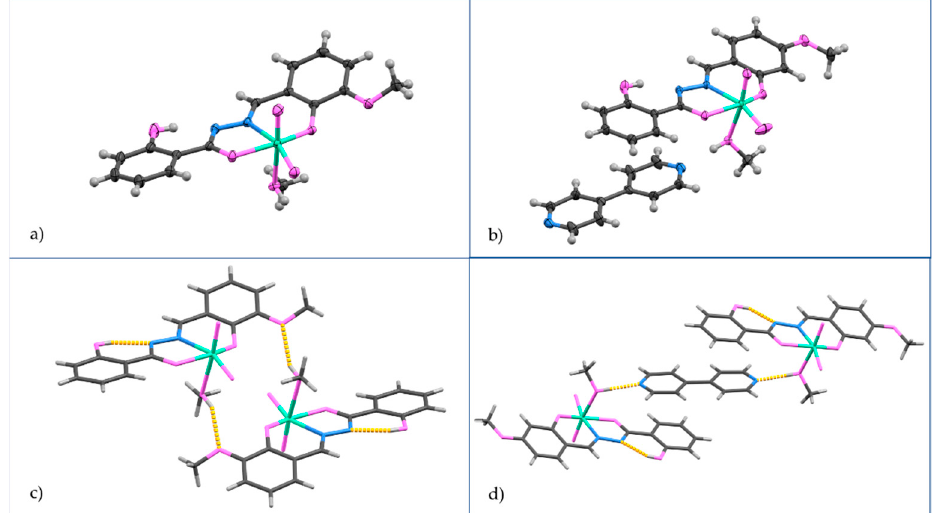
Figure 1. Molecular structure of ( a ) complex [MoO 2 (L 3OMe )(MeOH)] and ( b ) complex co-crystal [MoO 2 (L 4OMe )(MeOH)]·4,4-bpy. Carbon atoms are colored dark gray, hydrogen atoms light gray, oxygen atoms pink, nitrogen atoms blue, and molybdenum atoms turquoise. Molecules are connected via hydrogen bonds into supramolecular dimers. In the case of ( c ) [MoO 2 (L 3OMe )(MeOH)] hydrogen bonds are realized through methanol-methoxy group interaction, while in ( d ) [MoO 2 (L 4OMe )(MeOH)]·4,4-bpy they are realized through methanol–bipyridine interaction. Table 1. Selected geometrical parameters of complexes in the solid-state. Compound ONO Plane × Mo